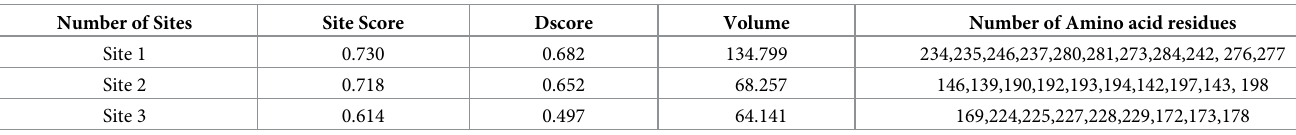
Table 2. SiteMap generated druggability site score